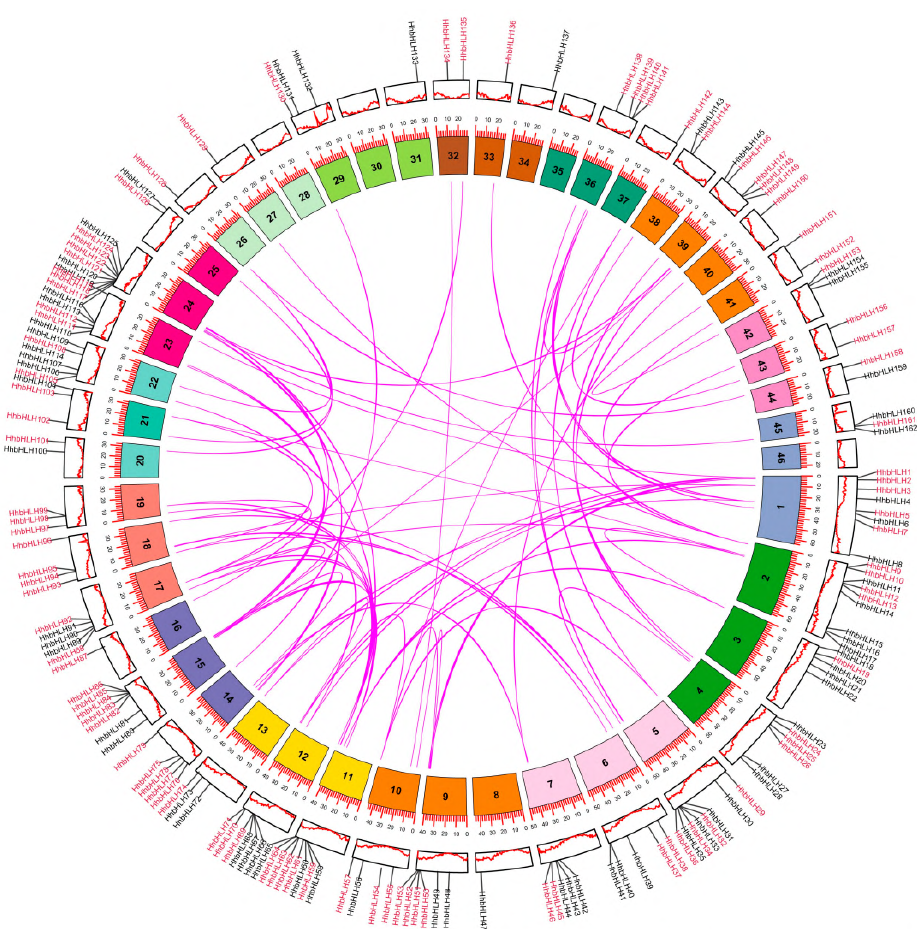
Figure 4. Distribution and collinearity of the HhbHLHs . Black lines along the circumference of the circle mark the positions of genes on chromosomes. The lines inside the circle indicate collinearity relationships among HhbHLH